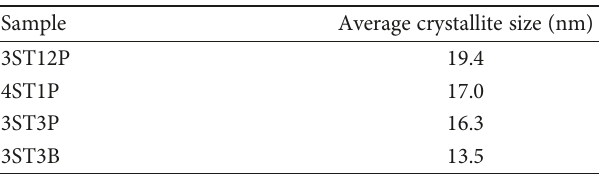
Table 2: Average crystallite size of the synthesized materials in Figure 4. Sample Average crystallite size